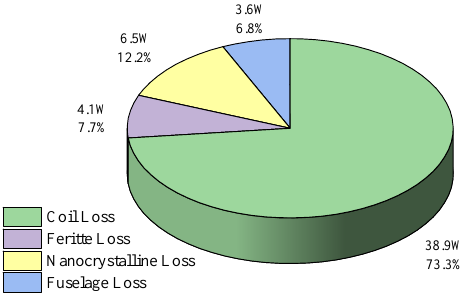
Figure 23. Loss distribution of the UAV magnetic coupler.